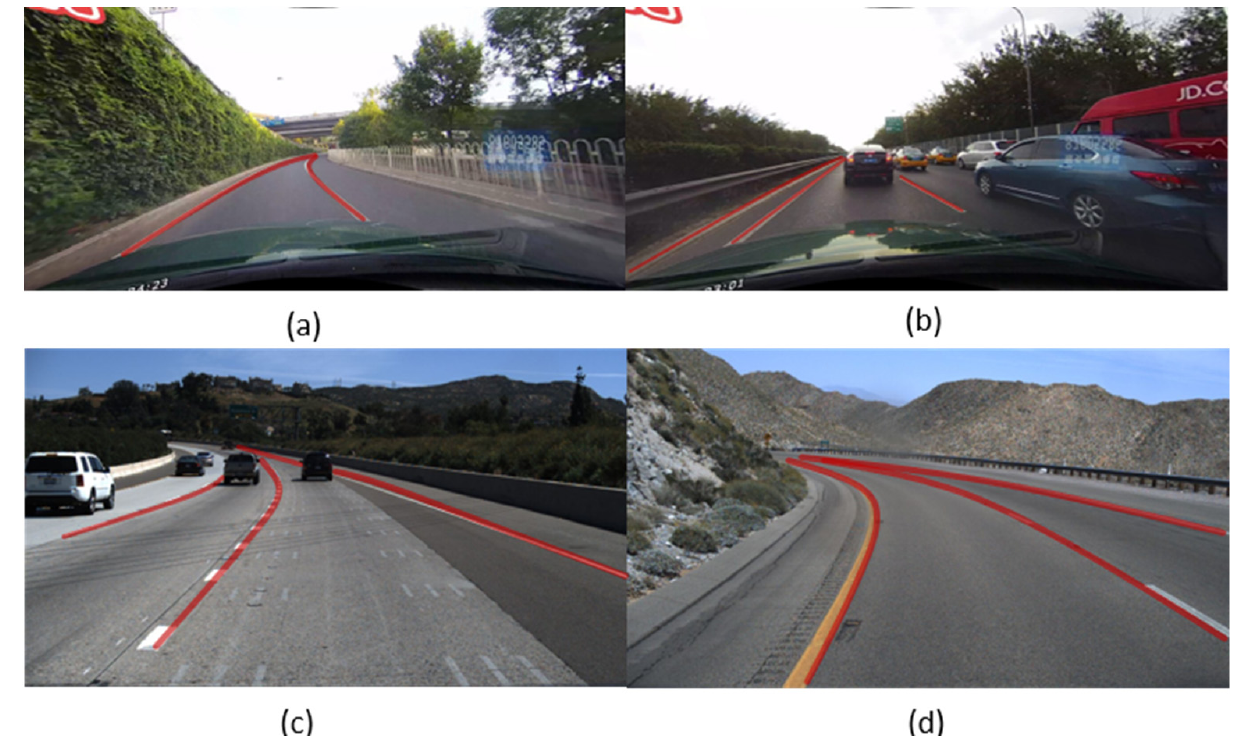
Figure 5. Our method visualizes images in different scenarios on the CULane datasets ( a,b ) and Tusimple datasets ( c,d ).